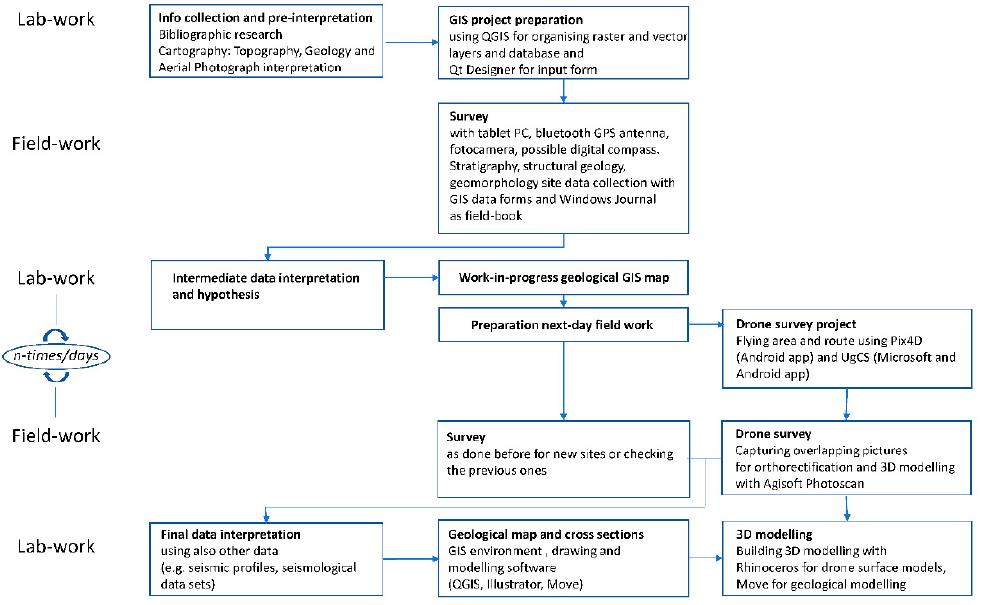
Figure 3. Methodological workflow with phases of the survey and mapping processes. Laboratory and field work alternated from the start to the end. At the beginning, the preparatory work was carried out in the laboratory. During the survey, data from the field can be used for interpretation and to check new hypotheses. The structure of the project can also be modified in order to improve the collection of data and observations, both for terrestrial and aerial surveys. Over the period of work, it was necessary to alternate laboratory and field work. In the last laboratory phase, the final interpretation and synthesis using two- and three-dimensional maps, cross-sections, and models took place.